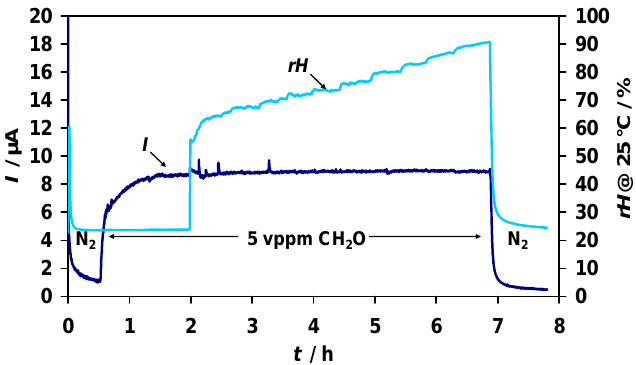
Figure 5. Sensor signal for 5 vppm formaldehyde with varied humidity in the range of 23 - 90 %rH.